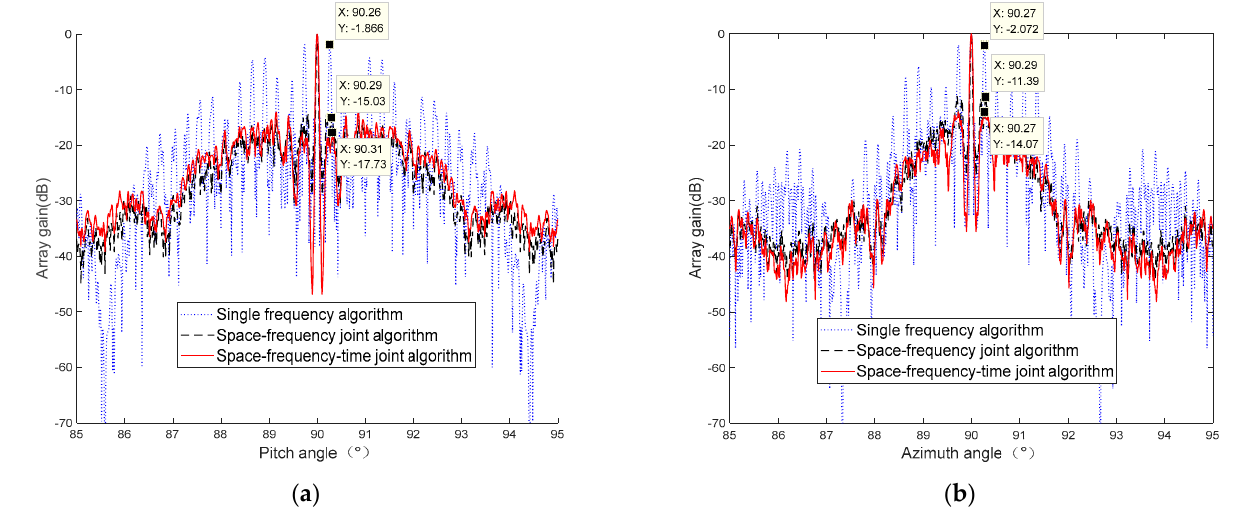
Figure 8. The beampattern under elevation angle of 90 and azimuth angle of 90. ( a ) The elevation pattern; ( b ) the azimuth pattern.